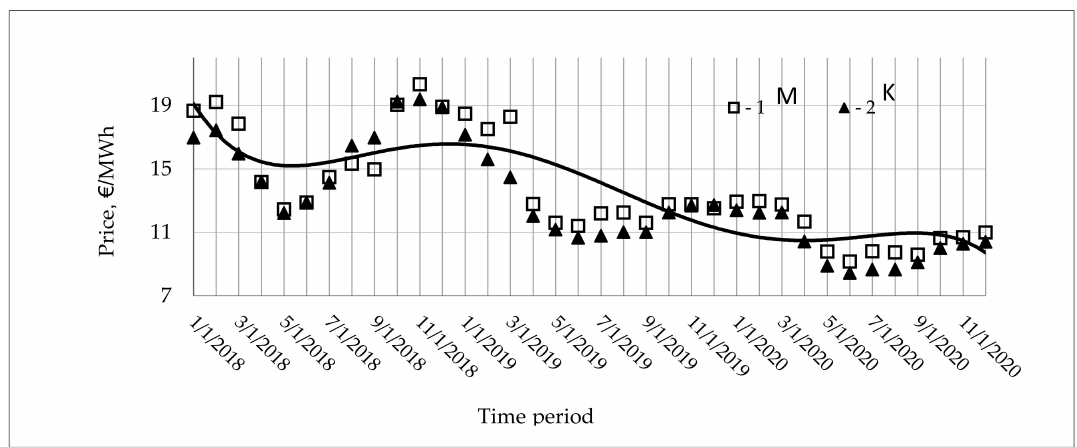
Figure 7. Changes of chip fuel prices at biofuel exchange during period 2018–2020 in counties, where companies M and K are